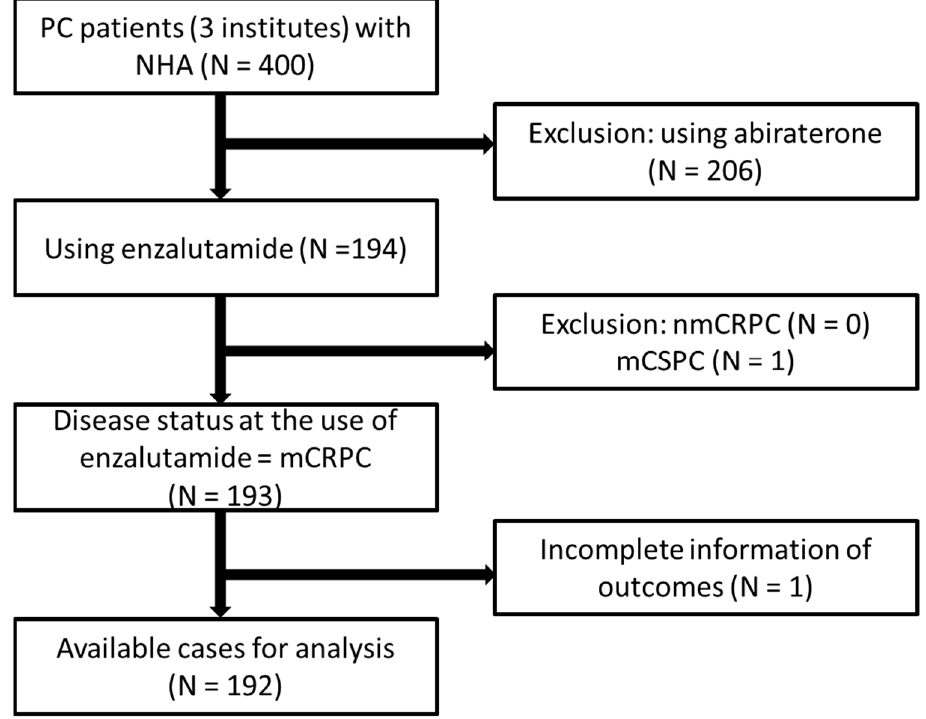
Figure 1. Patient selection flow diagram PC = prostate cancer; NHA = new hormonal agents including abiraterone acetate and enzalutamide; mCRPC = metastatic castration resistant prostate cancer; nmCRPC = non-mCRPC; mCSPC = metastatic castration sensitive prostate cancer.